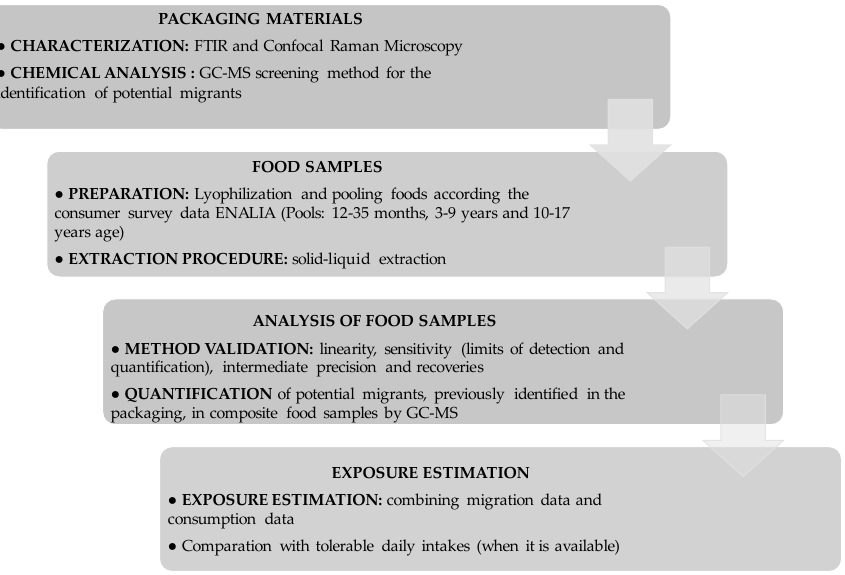
Figure 1. Scheme of the analytical protocol followed in this study.